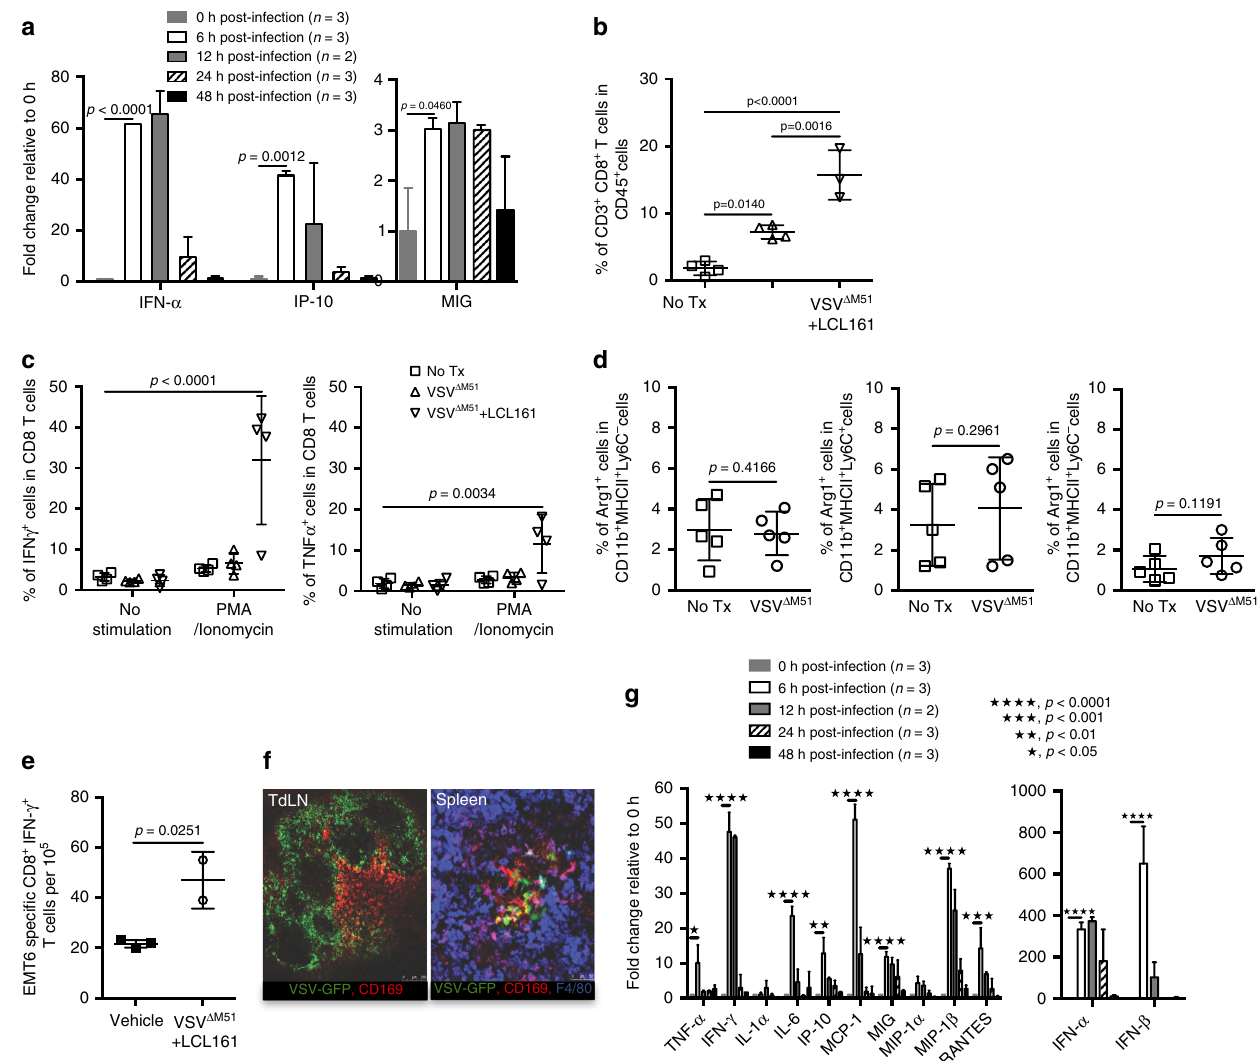
Fig. 4 VSV Δ M51 promotes T-cell accumulation within tumors and serves as a systemic immune system adjuvant. a Expression levels of T-cell promoting chemokines and cytokines within the interstitial fl uid of EMT6 tumors, measured by Luminex (duplicate experiments; mean ± SD; ANOVA with Tukey ’ s multiple comparisons test). b CD8 + T cells within EMT6 tumors 7 days post treatment, measured by fl ow cytometry (triplicate experiments; mean ± SD; ANOVA with Tukey ’ s multiple comparisons test). c Intracellular staining for IFN γ or TNF α within CD8 + T cells isolated from EMT6 tumors 7 days post treatment and stimulated with PMA and ionomycin ex vivo, measured by fl ow cytometry (duplicate experiment; mean ± SD; ANOVA with Tukey ’ s multiple comparisons test). d Intracellular staining for arginase-1 in CD11b + MHC-II ± Ly6C ± TAMs isolated from EMT6 tumors 72 h post treatment (single experiment; mean ± SD; t -test). e Activation of CD8 + T cells isolated from EMT6 tumors 8 days post treatment, after co-culture with EMT6 cells, measured by IFN γ ELISpot assay (single experiment; mean ± SD; t -test). f Representative IVM images of VSV Δ M51-GFP infection of TdLN and spleen, taken 8 h post-VSV Δ M51- GFP treatment ( n = 3 biological replicates). Scale bars for TdLN and spleen = 250 μ M and 50 μ M, respectively. g Cytokines within blood taken from EMT6 tumor-bearing mice treated with VSV Δ M51 , measured by Luminex (single experiment; mean ± SD; ANOVA with Tukey ’ s multiple comparisons exhaustion (Fig. 2a), the combination therapy induced a partial decrease in PD-1 expression on CD8 + TIL (Fig. 6d). In contrast, PD-1 levels increased in CD4 + T cells within both tumor and TdLN (Fig. 6d, e). LCL161 treatment led to decreased PD-L1 expression in some but not all subsets of TAMs (Fig. 6f). Taken together, these data show that PD-1 inhibition improves outcomes to LCL161 + Δ M51 , which we speculate is because the PD-1/PD-L1 signaling VSV axis remains partially intact within the TME after LCL161 + Δ M51 VSV treatment.